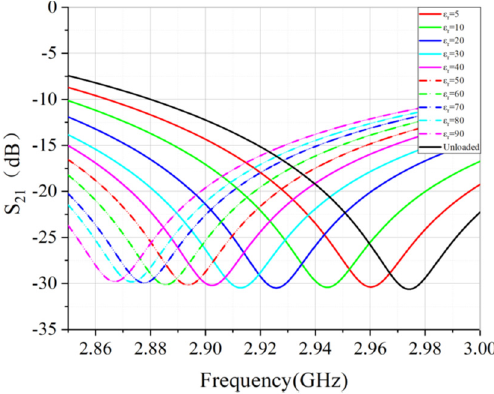
ε′ range from 5–90. Figure 8. (dB) magnitude of sensor for ε (cid:48) r range from